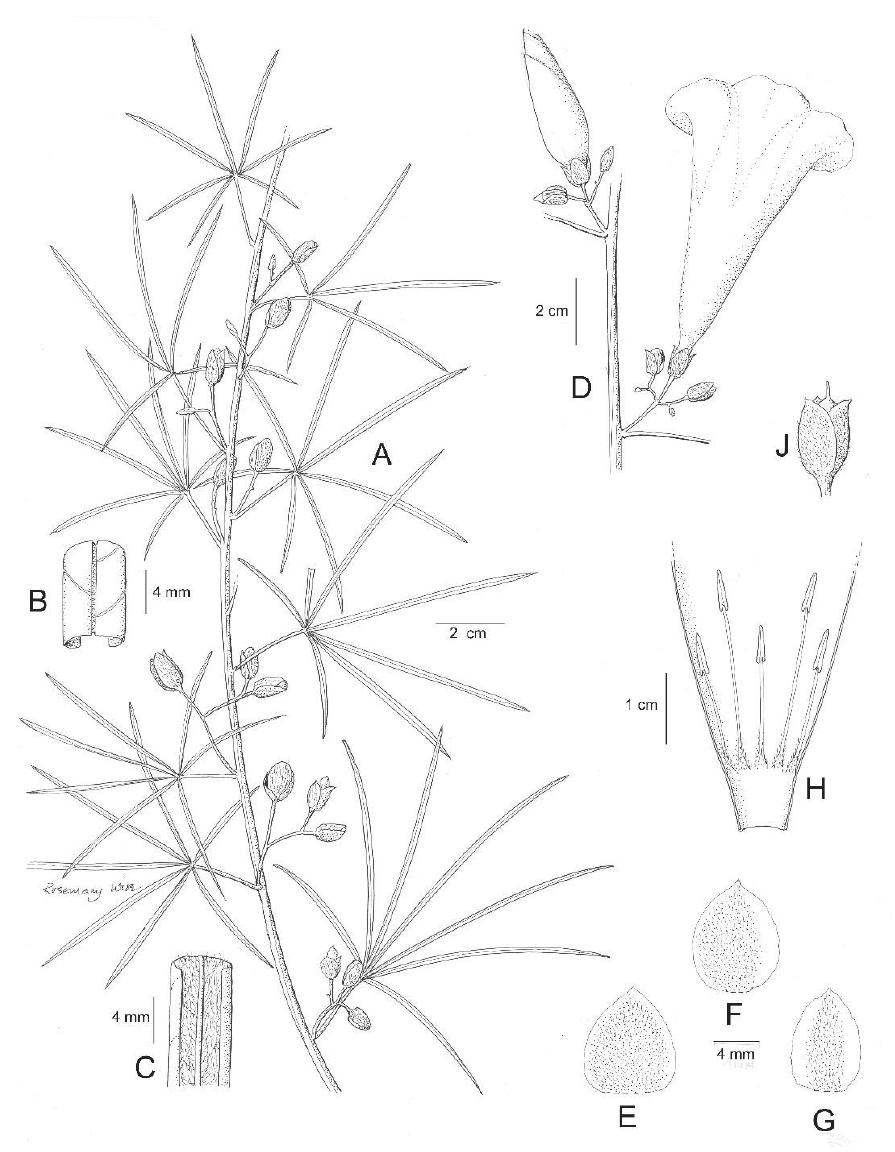
Figure 14. Ipomoea revoluta . A habit B adaxial leaf surface C abaxial leaf surface D inflorescence e outer sepal F middle sepal G inner sepal h corolla opened out to show stamens J calyx enclosing capsule. Drawn by Rosemary Wise from G. Hatschbach